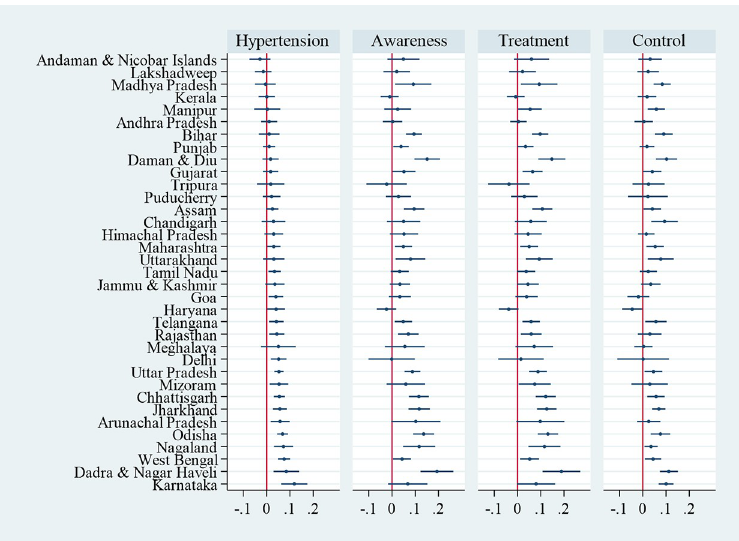
Fig 4. Adjusted concentration indices for hypertension and ATC among those with hypertension by states, adults aged 45 years and over and their spouses. Notes: A concentration index is a scaled covariance between an outcome and rank in the distribution of MPCE. Adjusted for age and sex. States ordered by concentration indices for hypertension. Dots indicate point estimates, and horizontal lines show 95% CIs. State-specific sample sizes presented in S5 Table and estimates in table format presented in S11 Table. ATC, awareness, treatment, and control; MPCE, monthly per capita consumption expenditure.